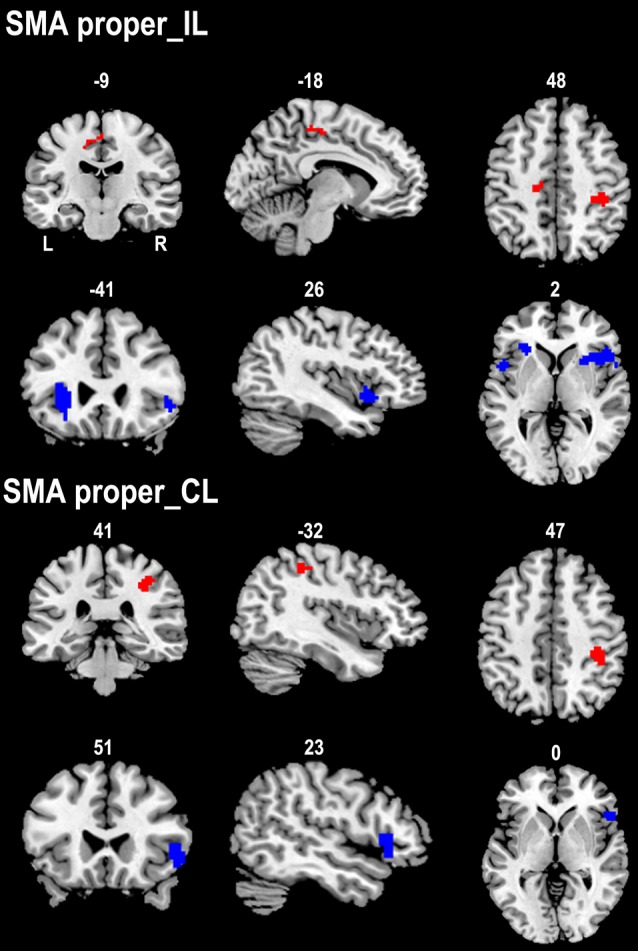
Contrast maps of the rsFCs of the SMA proper between stroke patients and healthy subjects. Red blobs and blue blobs indicate increased and decreased functional connectivity in patients compared with healthy subjects, respectively. CL, contralesional hemisphere; IL, ipsilesional hemisphere; rsFC, resting-state functional connectivity; SMA, supplementary motor area.